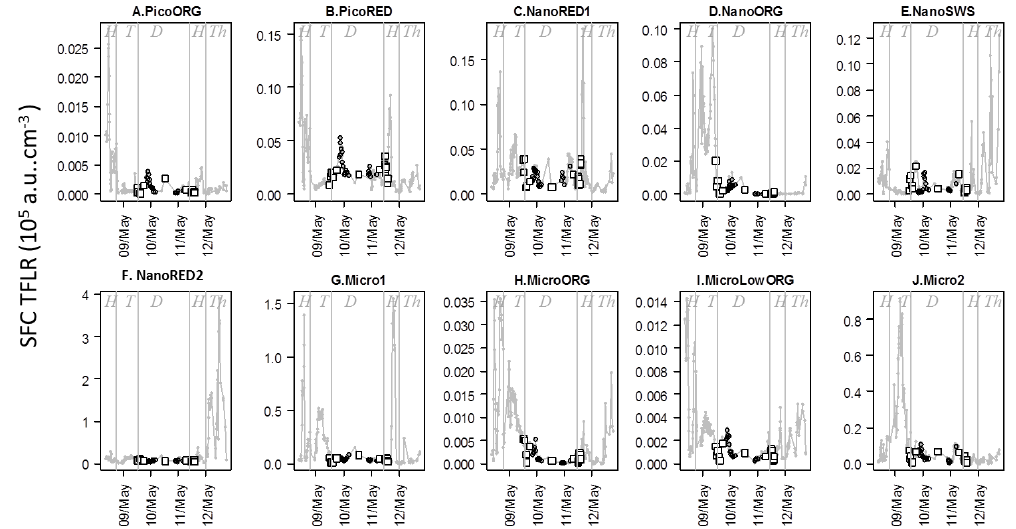
Figure 7. Scanning flow cytometer total red fluorescence per unit volume (SFC TFLRcm − 3 ) for each phytoplankton cluster. Superimposed large white squares are the matching points with MODIS pixels in non-turbid waters between 06:00 and 18:00. Diamonds correspond to the night SFC samples matching MODIS passage but are not taken into account because of the possible differences between day and night community structures. In order to show evidence of distribution, scales have not been homogenized. Grey bars separate the traversed marine areas: H, Humber; T, Tyne; D, Dogger; Th, Thames. Table 3. Minimal and maximal radiance anomaly (RA) values for each collected MODIS wavelength (nm) that characterizes the edges for the two PHYSAT RA spectra (N1 and N2) observed in this study. Node RA (412)nm RA (412)nm RA